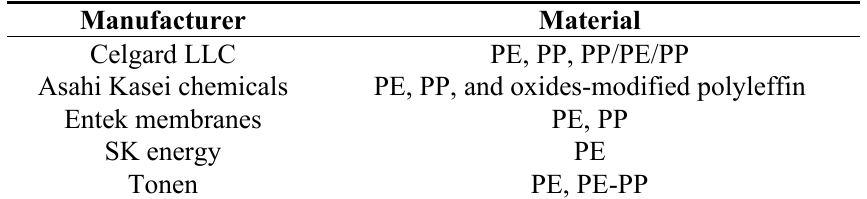
Table 2. Some commercial